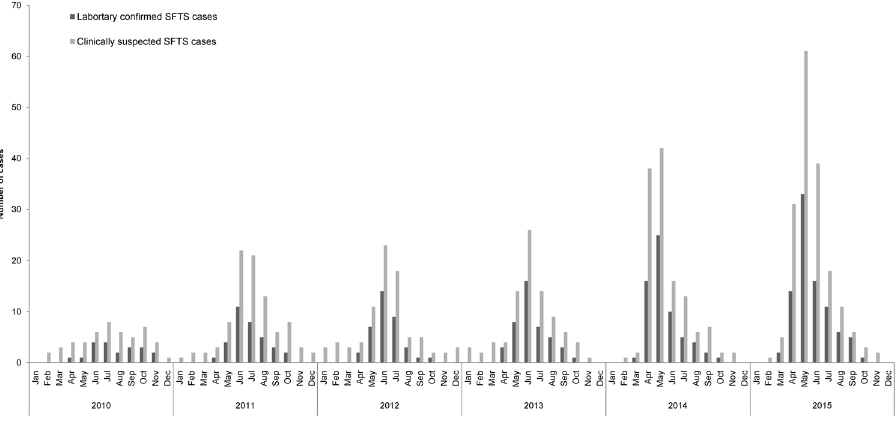
Figure 1. Epidemiological curve showing the seasonality of SFTS cases in Jiangsu and Anhui province during 2010 and